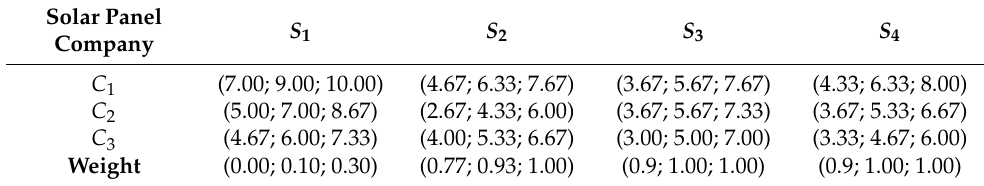
Table 11. Fuzzy decision matrix for M 3 .